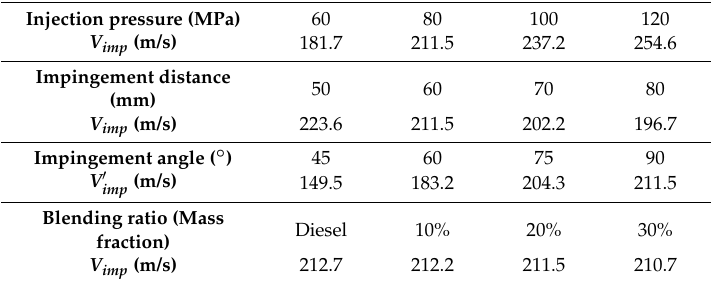
Table 4. Impingement velocity of different experimental conditions.